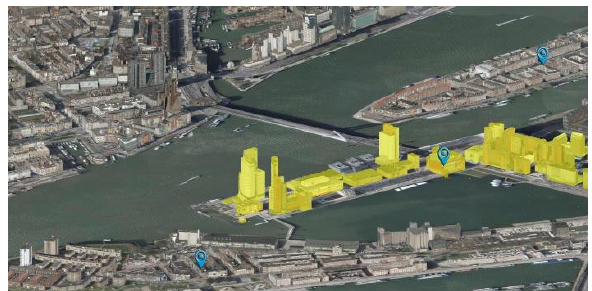
Figure 5. Example of an interactive 3D-visualisation using image based